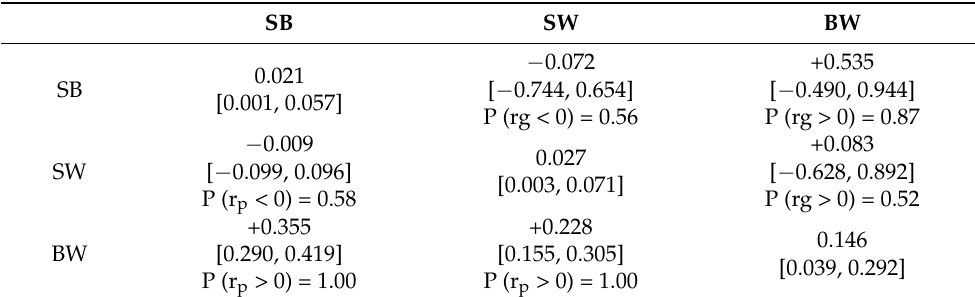
Table 5. Posterior means of heritabilities (diagonal), genetic correlations (above diagonal) and pheno- typic correlations (below diagonal) for survival at birth (SB) and at weaning (SW), and individual birth weight (BW) after adjustment for litter